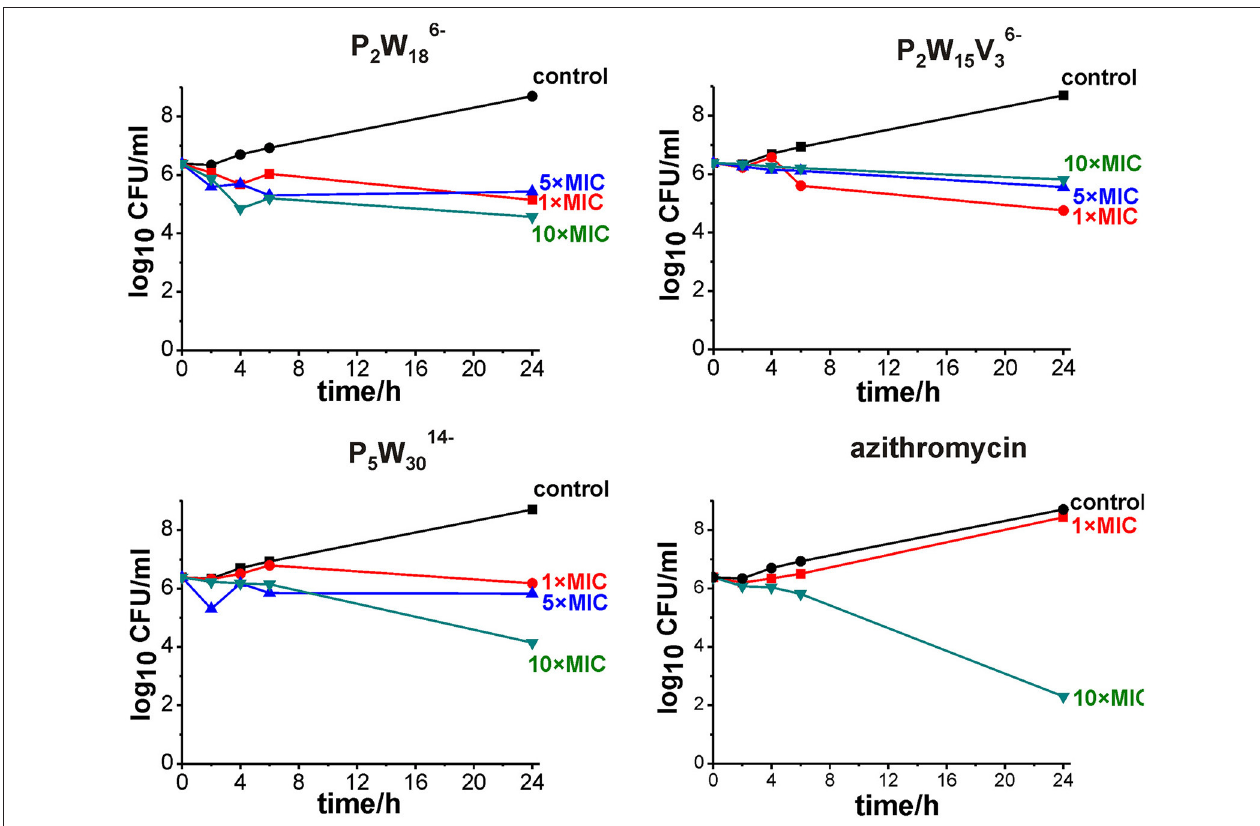
FIGURE 4 | Time-kill curves for Dawson P 2 W 6 − 18 and P 2 W 15 V 6 − 3 , Preyssler P 5 W 14 − 30 POTs and azithromycin at minimum inhibitory concentration (MIC) (red), 5-fold (blue) and 10-fold MIC concentration (green) against M. catarrhalis ATCC23246 strain. Control represents uninhibited bacterial growth